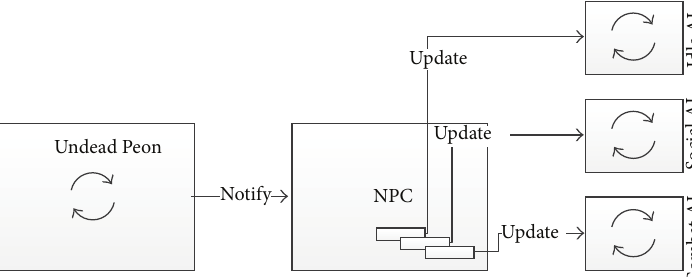
Figure 10: Updating the internal state of AI controllers when game objects update theirs. Note how objects in CDS do not have an update cycle.